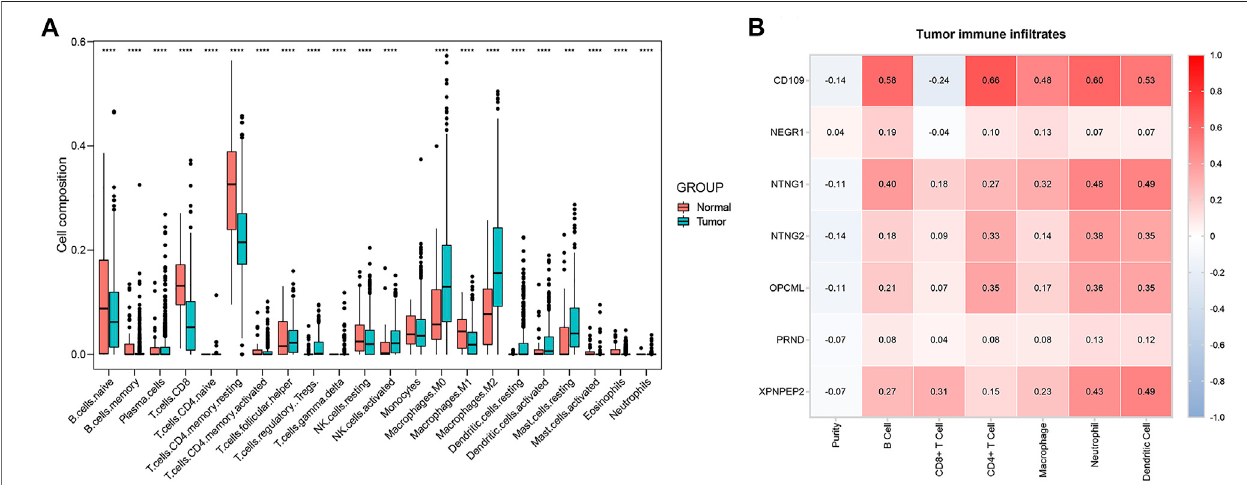
FIGURE10| Boxplot of22immune cells compositioninTHCA and normal tissue group (A) .The correlation ofcriticalgenesand tumor immune in fi ltrates analyzed via the Tumor Immune Estimation Resource (TIMER) platform (B) . Red: positive correlation; blue: negative